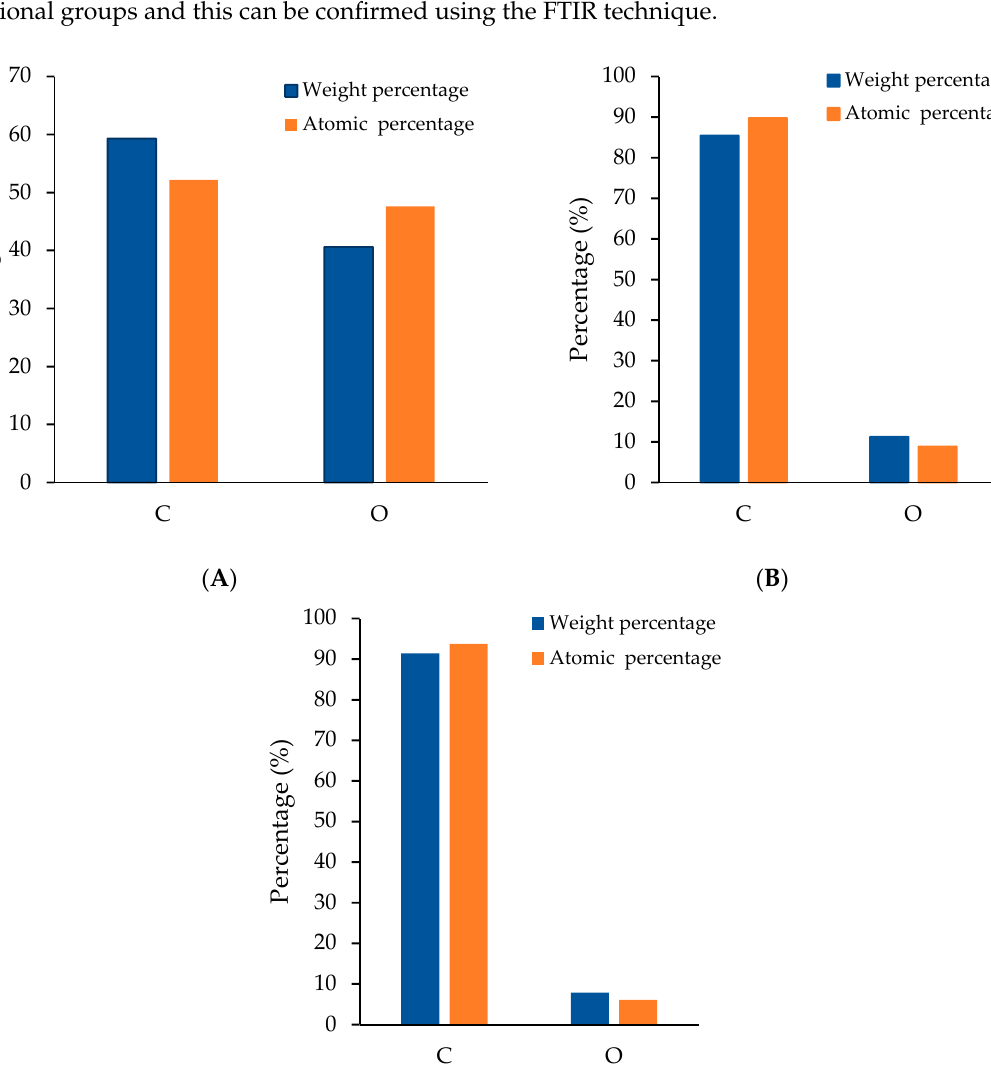
Figure 5. SEM for raw macadamia nut shell ( A ) and pyrolyzed at 900 °C ( B ) and 1000 °C ( C ).